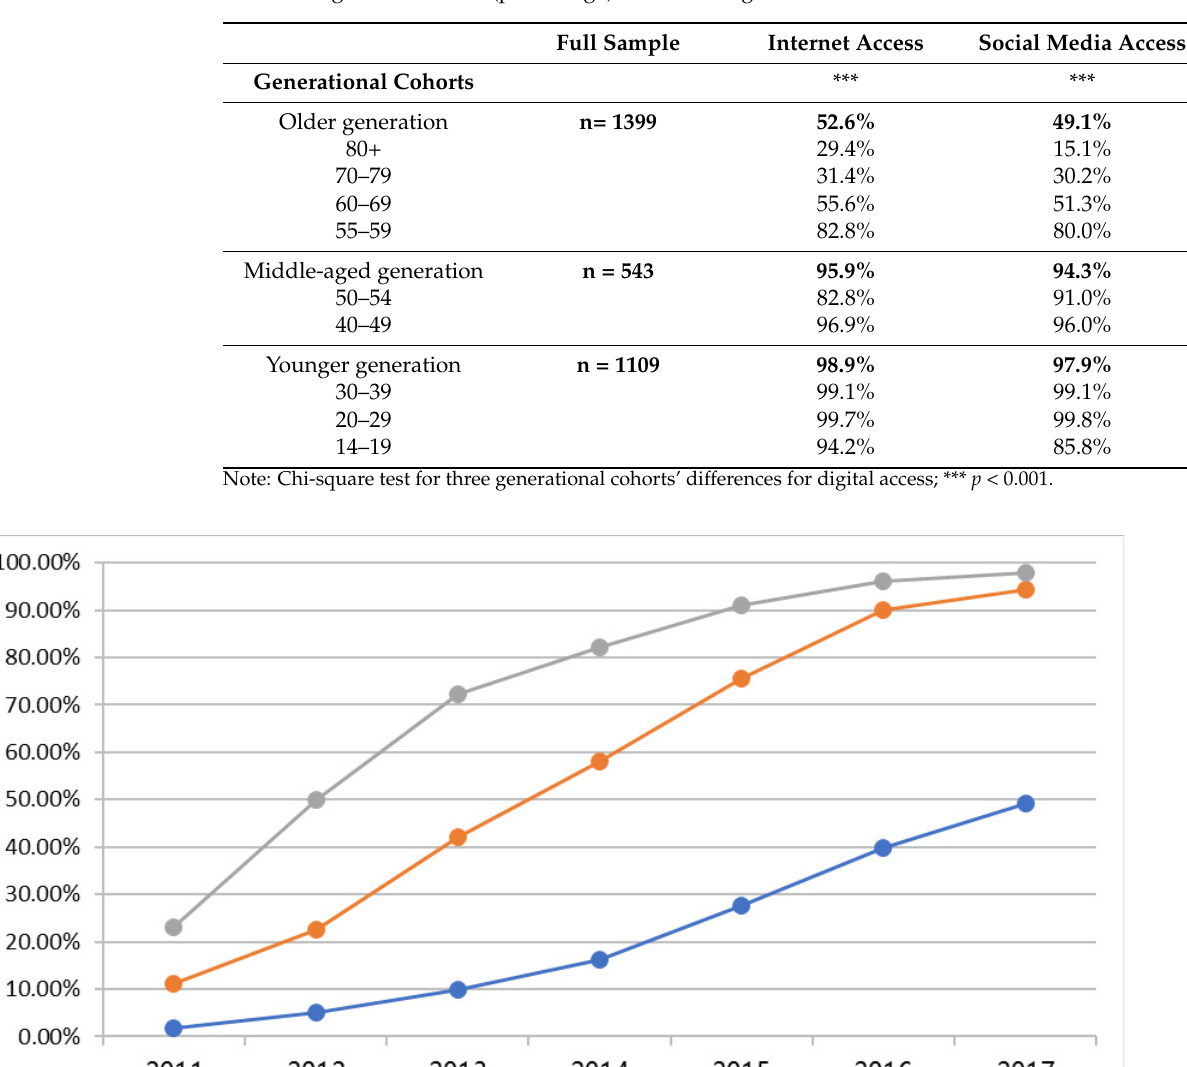
Table 1. Digital access rate (percentage) within each generational cohort.